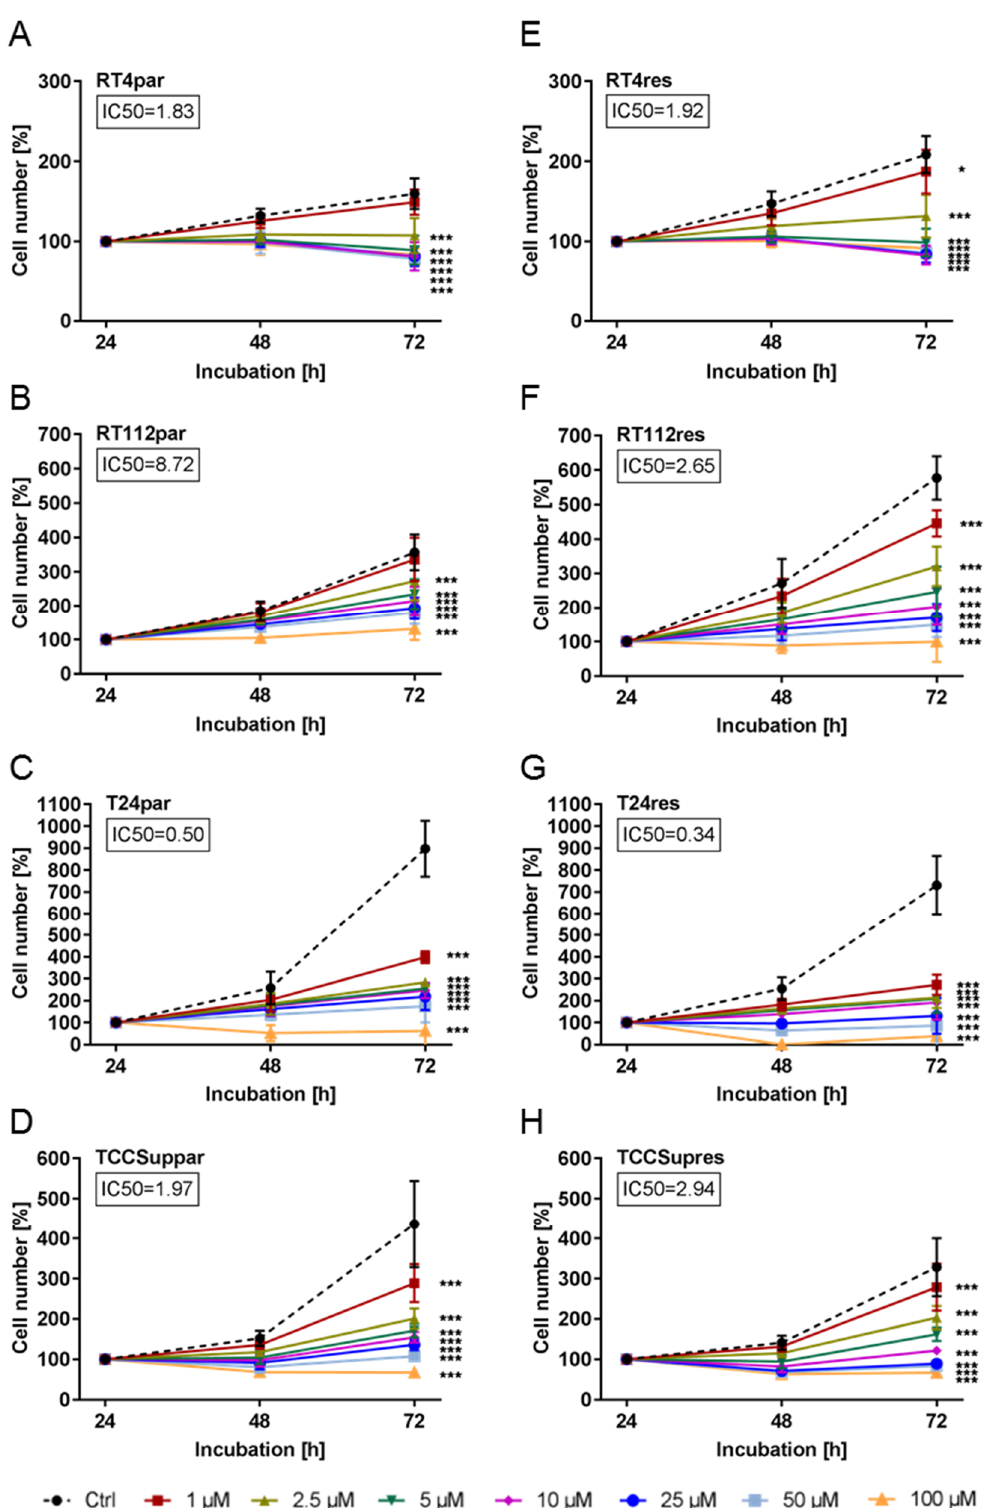
Figure 1. Tumor cell growth: Tumor cell growth (MTT-test) of parental (par) and cisplatin-resistant (res) RT4 ( A , E ), RT112 ( B , F ), T24 ( C , G ), and TCCSup ( D , H ) bladder cancer cells after 24, 48, and 72 h treatment with ascending concentrations of ART (1–100 µM). Cell number set to 100% after 24 h incubation. The half-maximal inhibitory concentration (IC50) of ART in µM after 72 h treatment is specified. Error bars indicate standard deviation ( SD ). Significant di ff erence to untreated control: * p ≤ 0.05, *** p ≤ 0.001. n =